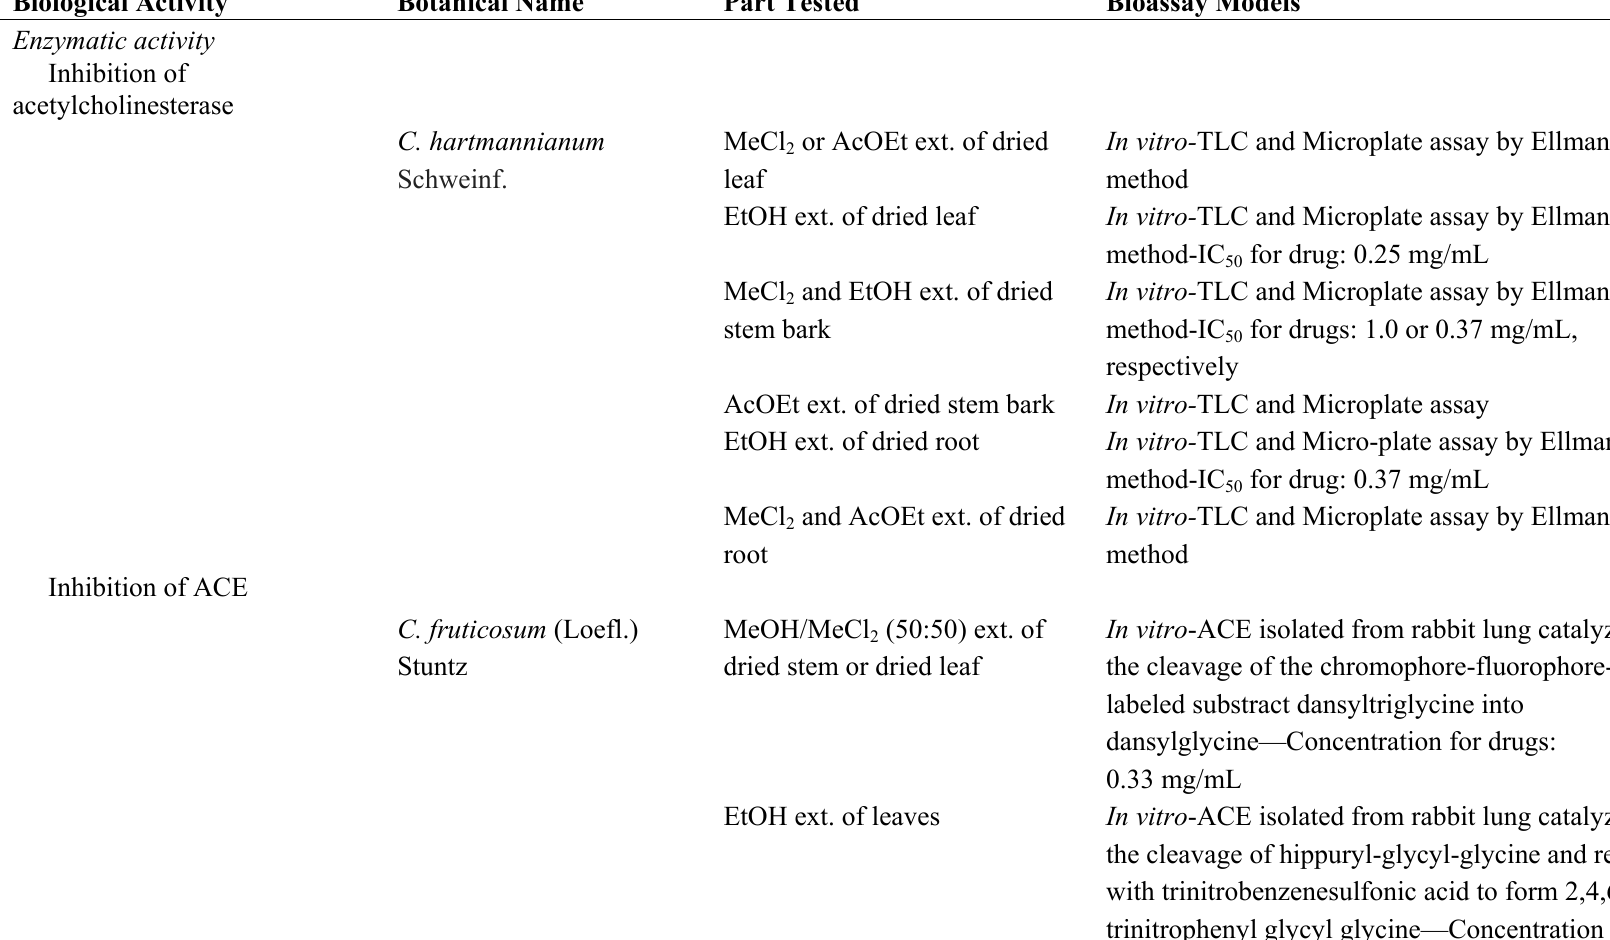
Table 1. Bioactivities of drugs obtained of the genus botanical Combretum